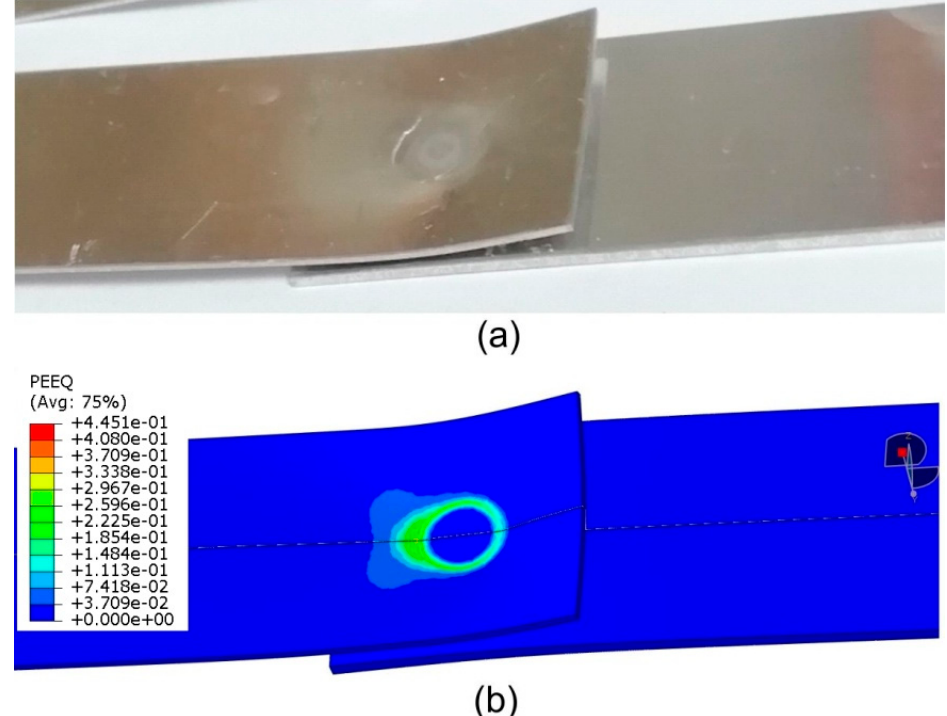
Figure 24. Comparison of the view of specimen ( a ) fabricated at tool rotational speed n = 2400 rpm and duration of welding t = 3.5 s (experiment E2) with ( b ) result of the distribution of plastic strain magnitude; displacement 1.8 mm.